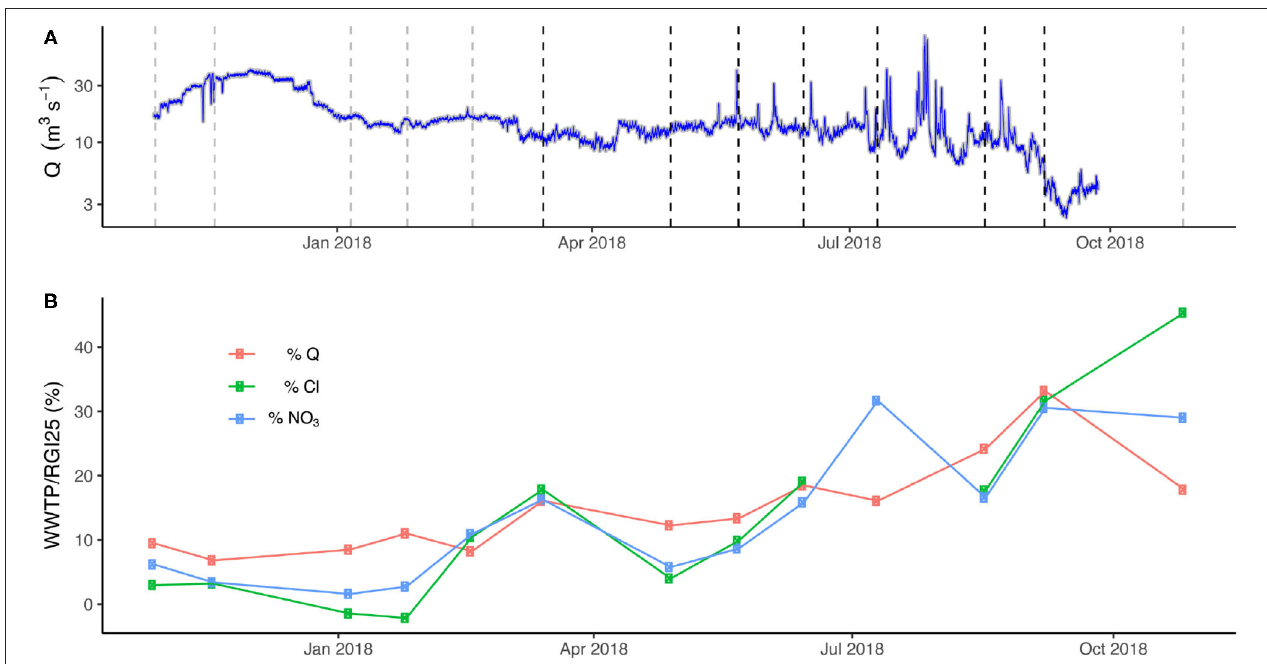
FIGURE 3 | (A) Hydrograph from the Rio Grande at Central Bridge in Albuquerque (Rio Grande S0) during the study period. Dashed lines show sampling dates (growing season in black, non-growing season in gray). (B) Influence of the ABQ WWTP on discharge (Q), Cl, and NO 3 -N values observed in the Rio Grande at I-25 bridge, which is located ∼ 9km downstream of